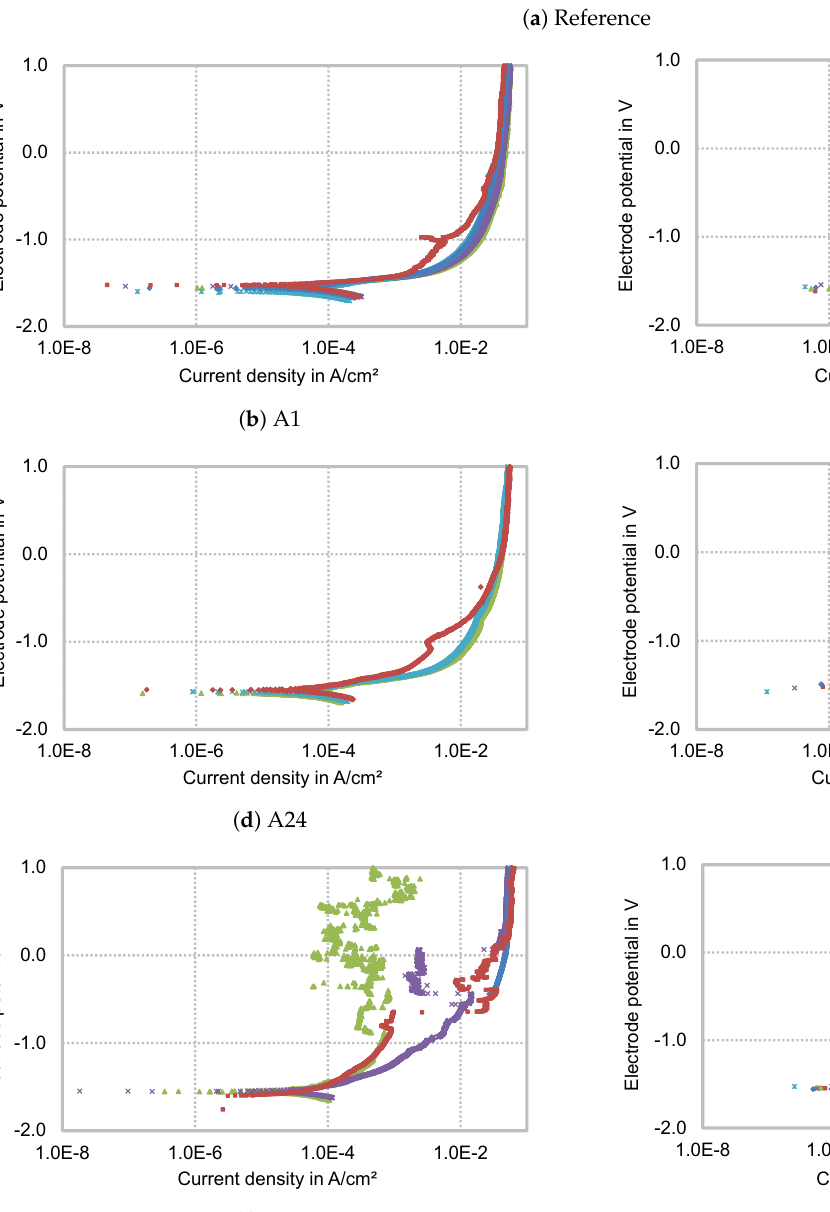
Figure 4. Polarisation curves of the platelets in dependence of the heat treatment duration and the cooling condition (n=3 to 5). The electrode potential (in V) is plotted as a function of current density (in A/cm 2 ). The current density is plotted